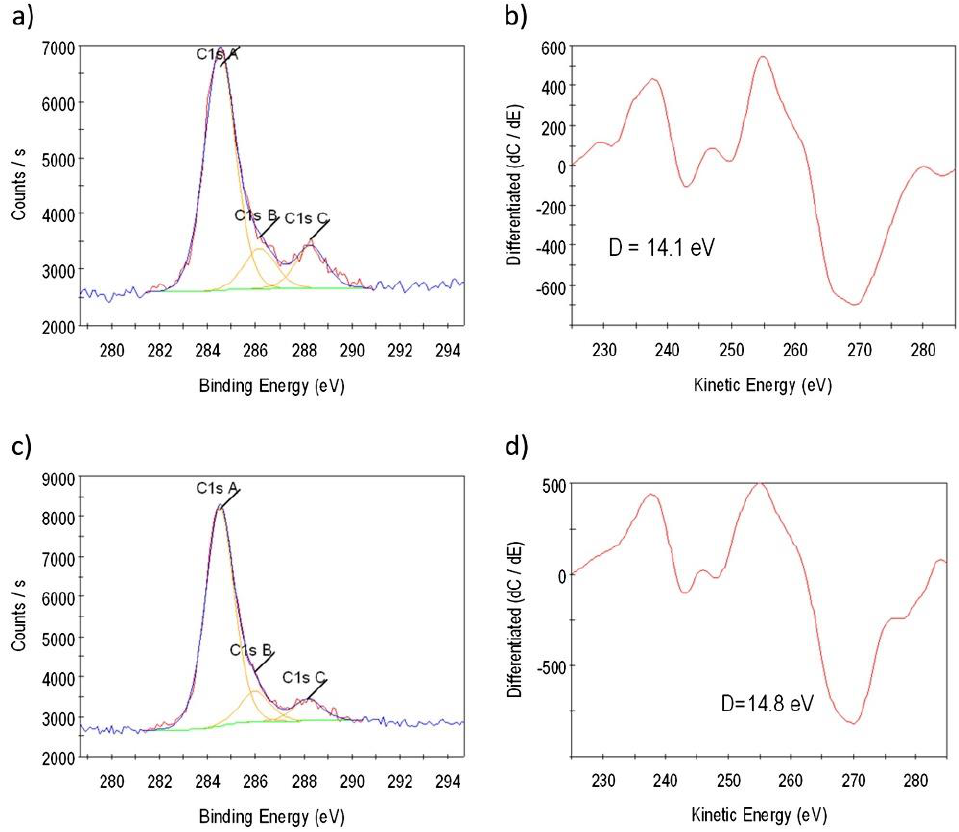
Figure 30. XPS spectra of C 1s for the samples 4 ( a ) and 6 ( c ) grown on Cu at 1000 °C. The corresponding C KLL spectra in the first derivative are shown in ( b ) and ( d ), respectively [47]. Table 2. Summary of XPS results for Sample 4 of graphene on Cu substrate [47].